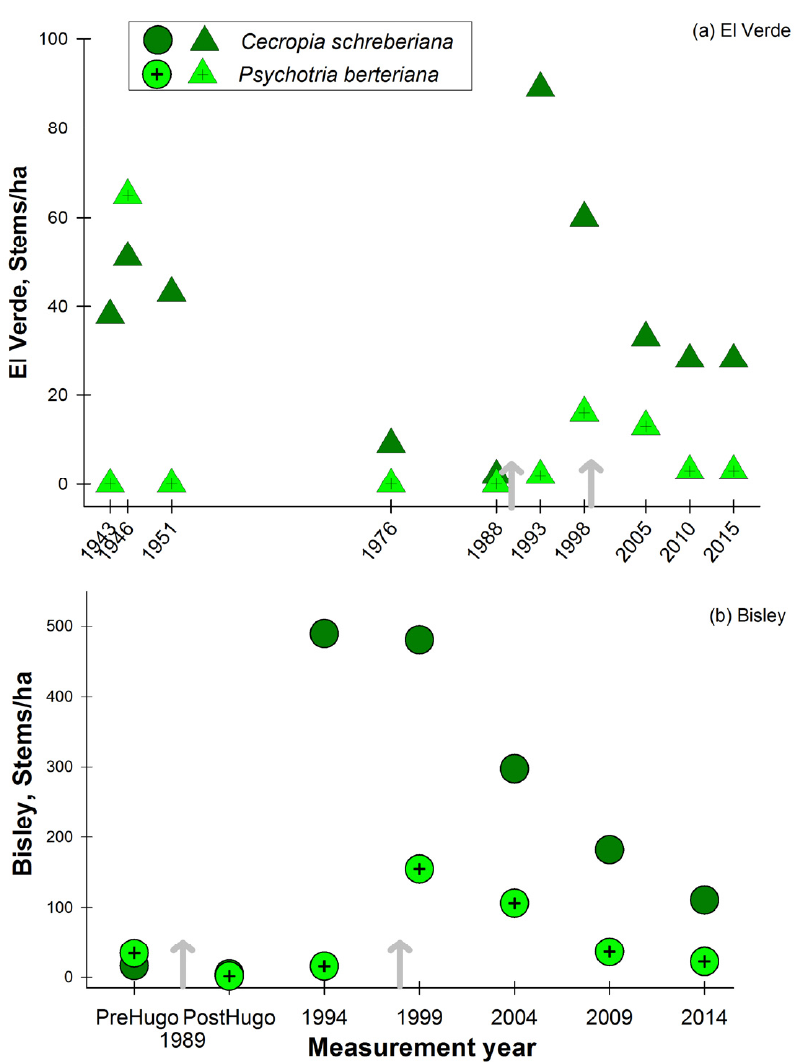
Figure 7. Stem density per each census year for selected shade intolerant/early successional species in two long-term research plots, Luquillo Experimental Forest, Puerto Rico. Panel ( a ) El Verde, with triangle symbols; panel ( b ) Bisley with circle symbols.